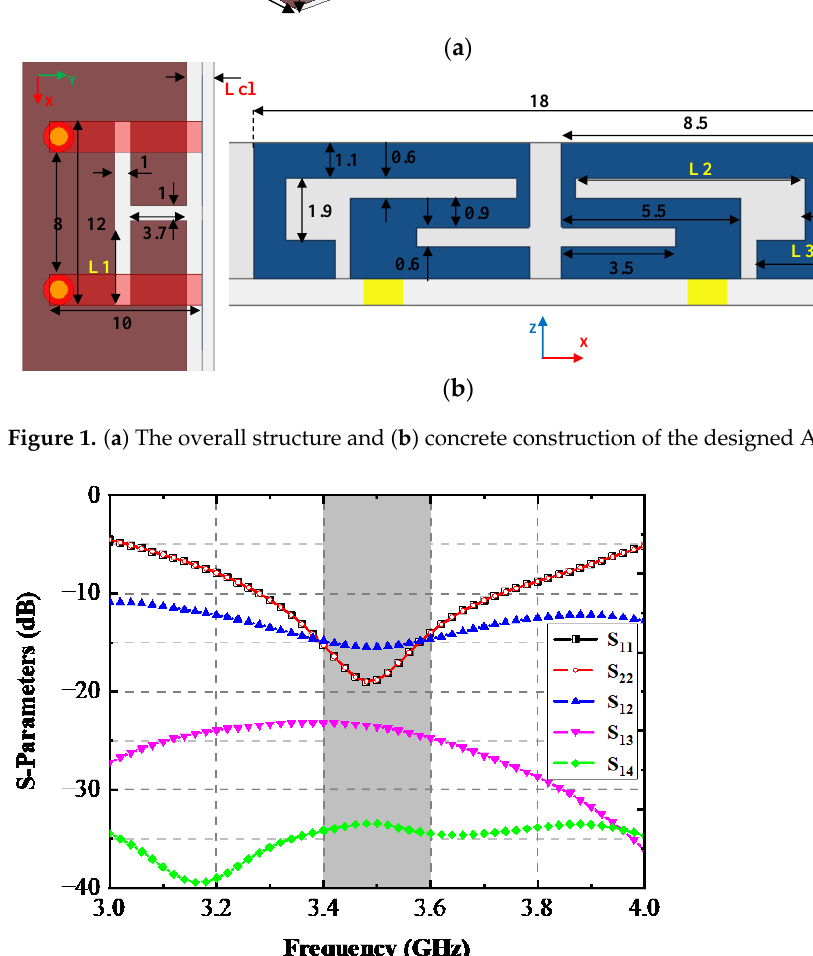
Figure 2. Simulated S-parameters.